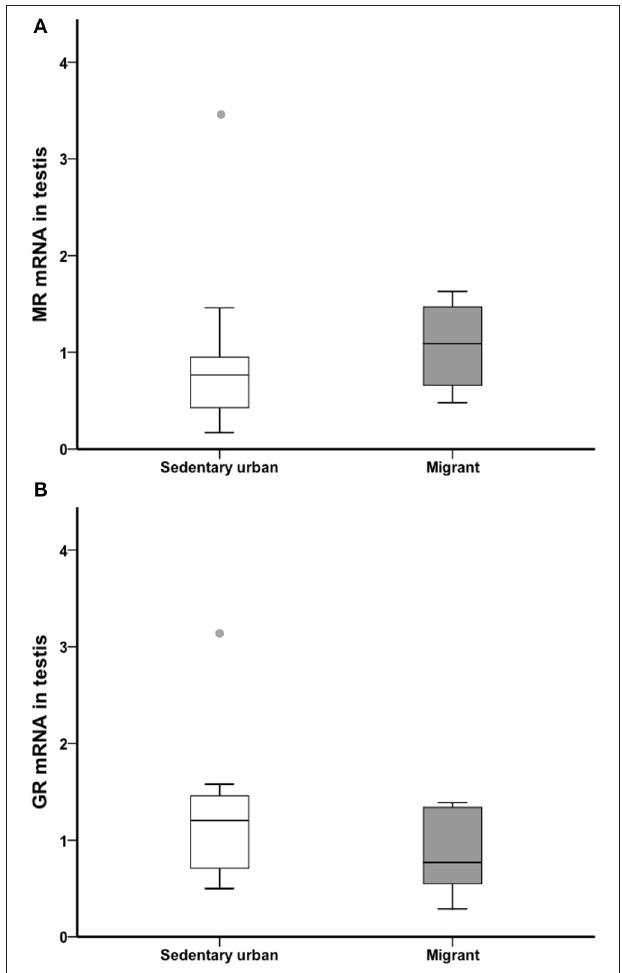
FIGURE 7 | Male sedentary urban juncos (white boxes) and male migrant juncos (gray boxes) did not differ in MR (A) or GR (B) transcript abundance in the gonad. Measures of transcript abundance are log 2 -fold change relative to a calibrator. Boxes represent upper quartile, median, and lower quartile. Whiskers include the range of values except for outliers. Outliers include values > 1.5 box lengths